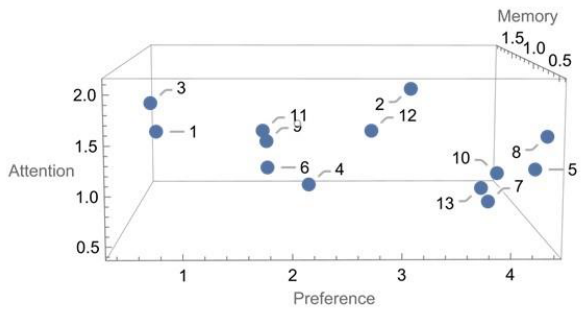
Figure 2. Three-dimensional graph of the efficient solution set.